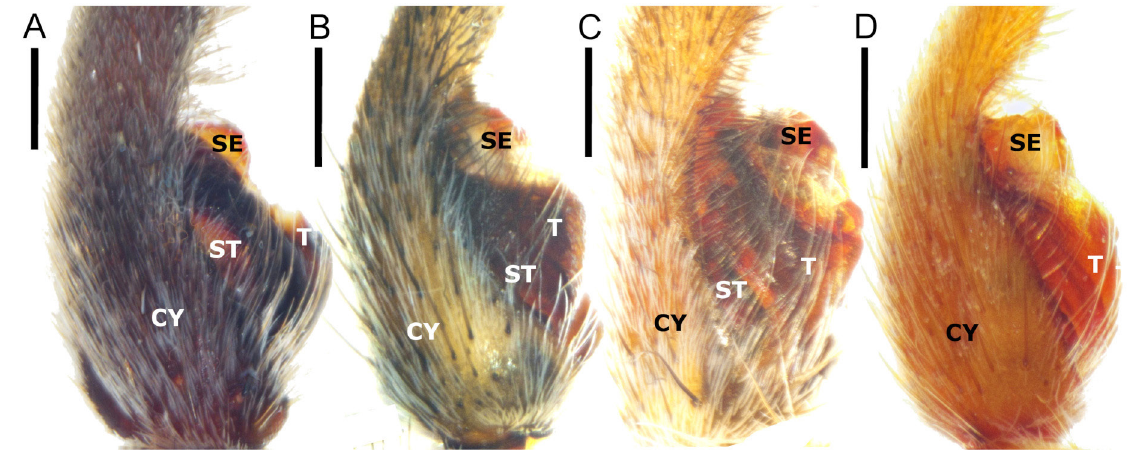
Fig. 4. Male pedipalps retrolateral view. A . Geolycosa vultuosa C.L. Koch, 1838 (HUJ INV-AR20960) . B . Lycosa gesserit sp. nov . , holotype (HUJ INV-AR20631). C . Lycosa hyraculus sp. nov., holotype (HUJ INV-AR20818) . D . Lycosa piochardi Simon, 1876 (HUJ INV-AR20948). Scale bars = 0.5 mm. Photos by I. Armiach